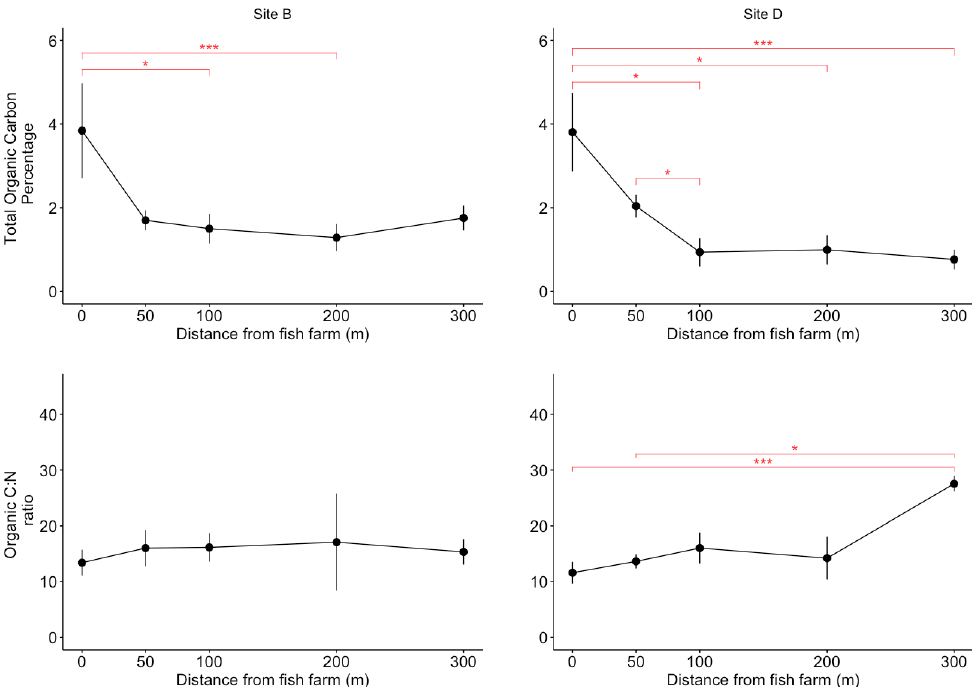
Figure 3. Plot of total organic carbon percentage and organic C:N ratio by station along transects. Asterisks represent statistically significant difference between different stations (***: p -value < 0.001; **: p -value < 0.01; *: p -value < 0.05).